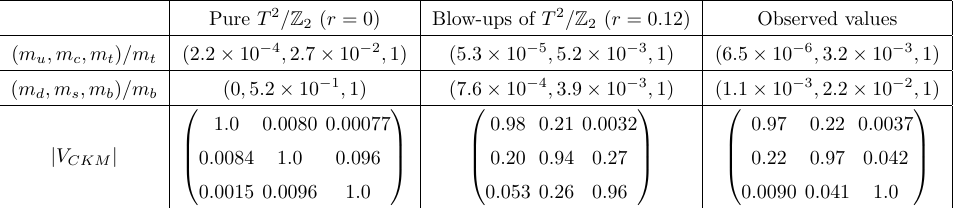
Figure 5 . The blow-up radius ( r )-dependence of the CKM mixing angles V 12 ( V 21 ), V 23 ( V 32 ), and V 13 ( V 31 ), as shown in the red (black)